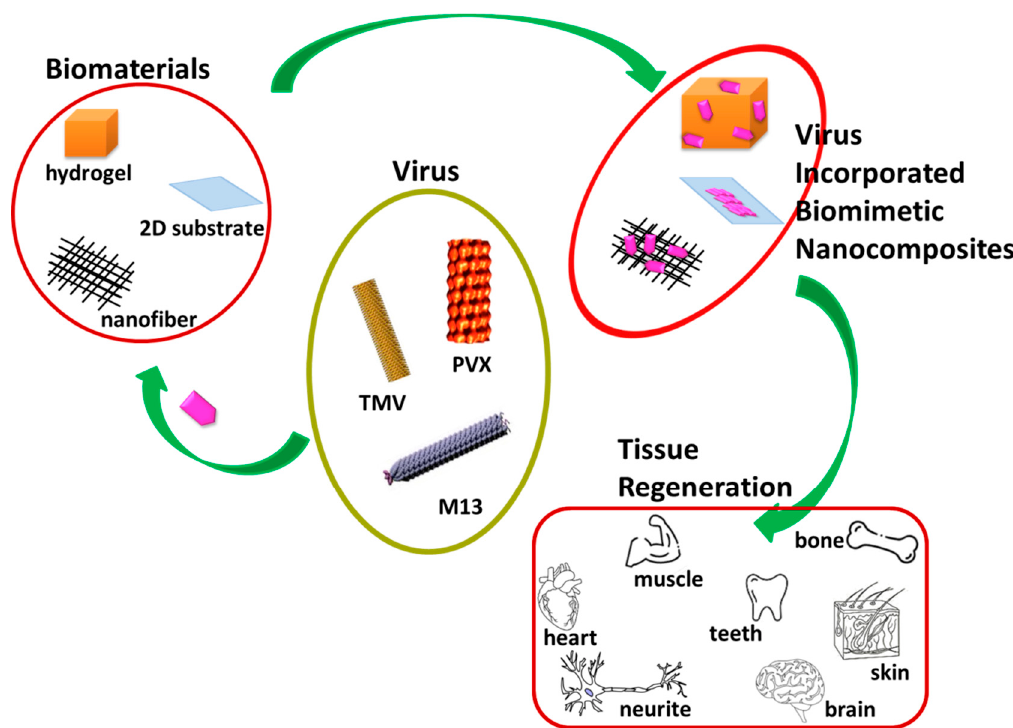
Figure 1. A compendium of tissue regeneration functionality of various virus incorporated biomimetic nanocomposites. Plant-based viruses Tobacco Mosaic Virus (TMV) and Potato Virus X (PVX) and bacteriophage M13 were shown. Reproduced with permission from [31]. Copyright Elsevier, 2010.